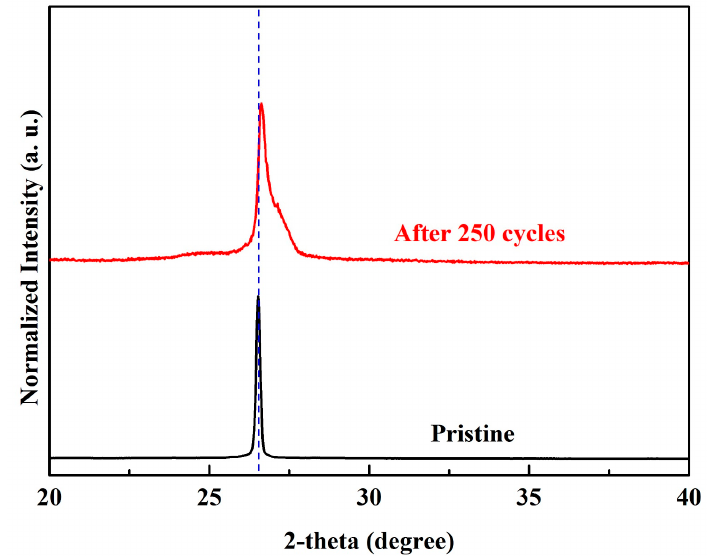
Figure 6. Electrochemical properties of the 10 mg/cm 2 graphite electrode at 100 mA/g: ( a ) long-term stability test; ( b ) discharge–charge curves at constant current of 100 mA/g (1C); ( c ) Raman spectra for pristine, fully charged, and discharged graphite electrodes.